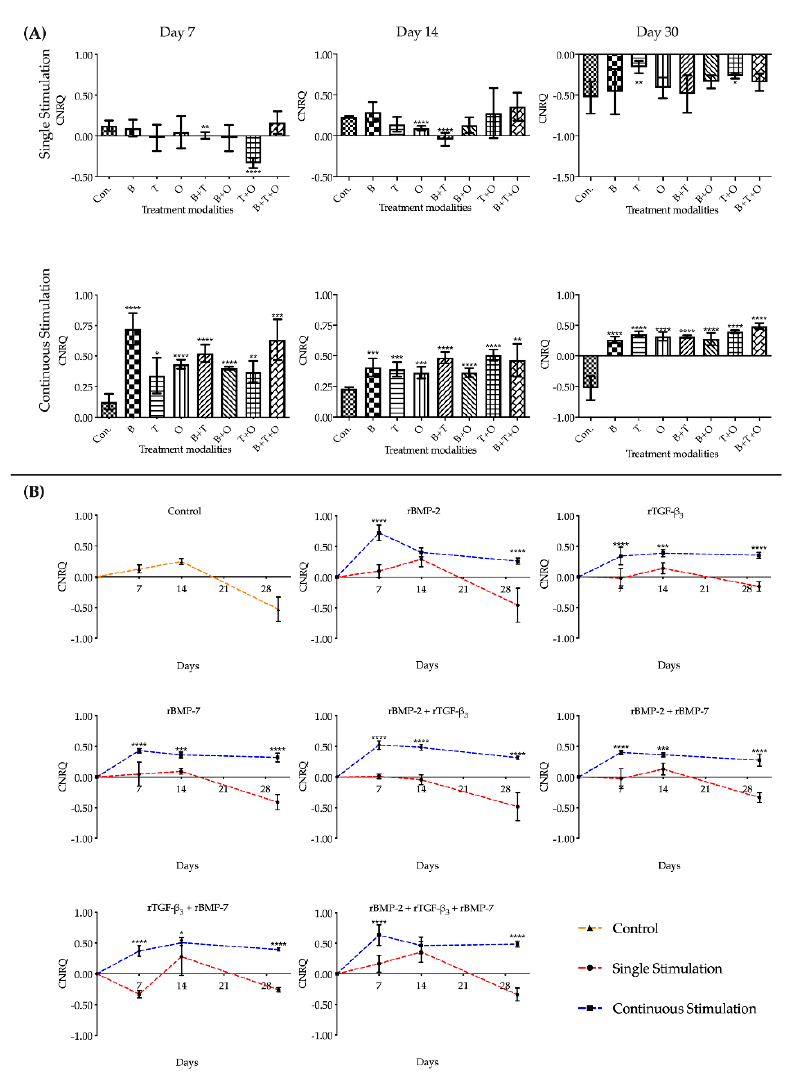
Figure 2. The analyses of the relative gene expression levels of SRY (Sex Determining Region Y)-Box 9 ( SOX9 ). The results were presented as calibrated normalized relative quantity (CNRQ). ( A ) Comparisons between each experimental group under different stimulation modes and the corresponding control group at day 7, 14 and 30 using one-way ANOVA. ( B ) Comparisons between the experimental groups where growth factors were applied continuously and the corresponding 48 h withdrawal groups at day 7, 14 and 30 using two-way ANOVA. Con. = control group, B= rBMP-2 treated group, T = rTGF- β 3 treated group, O = rBMP-7 treated group, B + T = rBMP-2 + rTGF- β 3 treated group, B + O = rBMP-2 + rBMP-7 treated group, T + O = rTGF- β 3 + rBMP-7 treated group, B + T + O = rBMP-2 + rTGF- β 3 + rBMP-7 treated group. Number of replicates ( n ) = 6. We defined p < 0.05 as a statistically significant difference. * p < 0.05, ** p < 0.01, *** p < 0.001, **** p < 0.0001. In ( A ) statistical significance is expressed between each group and the control group (normal medium), while in ( B ) it is expressed in each time point between continuous stimulation and single stimulation. The baseline 0 represents fresh non-cultured muscle tissue which was the normalization factor. The interactions between the stimulation duration and the culture sampling time in different treatment modalities groups were significant when using two-way ANOVA. Analysing the gene expression patterns in the groups applied morphogen(s) continuously over time for SOX9 , the relative upregulated expression level in the rBMP-2 group sharply decreased significantly from day 7 to 14, after which a stable lower upregulated expressional state was maintained. The most of other treatment groups remained stable after reaching a peak on day 7. Although rTGF- β 3 and rTGF- β 3 + rBMP-7 groups